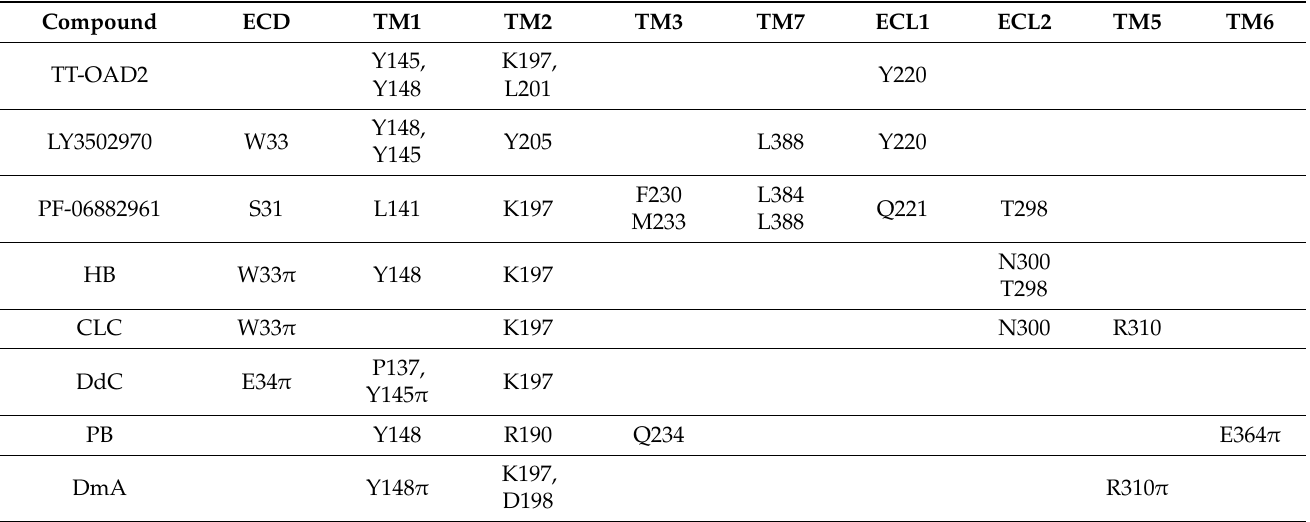
Table 2. Comparison of the effects of cyclopeptide and nonpeptide GLP-1 agonists on the seven α -helix and adjacent regions of the GLP-1